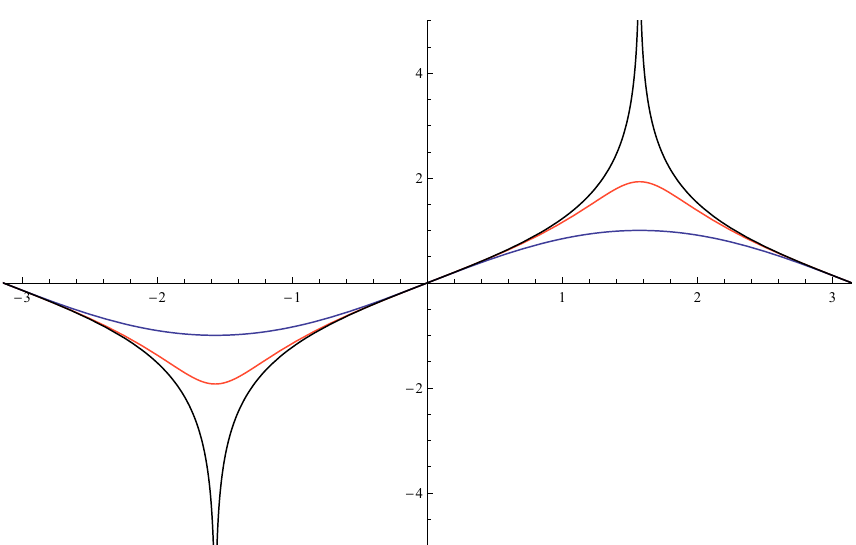
Figure 2 . Plot of the smoothed inverse Gudermannian function gd (cid:0) 1 ( x; ^ z ) at ^ z = 0 : 95, in the fundamental interval ( (cid:0) (cid:25); (cid:25) ). The sine function and the inverse Gudermannian functions are also plotted for